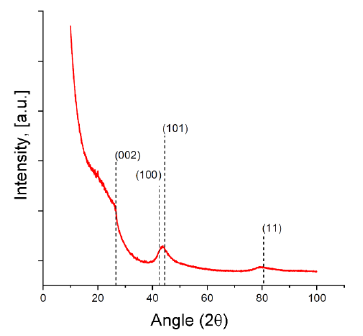
Figure 4. X-ray diffraction (XRD) patterns for the SiC-AC carbon adsorbent. The primary diffraction Figure 4. X ‐ ray diffraction (XRD) patterns for the SiC ‐ AC carbon adsorbent. The primary diffrac ‐ tion peaks of graphite are shown by dashed lines. peaks of graphite are shown by dashed lines.